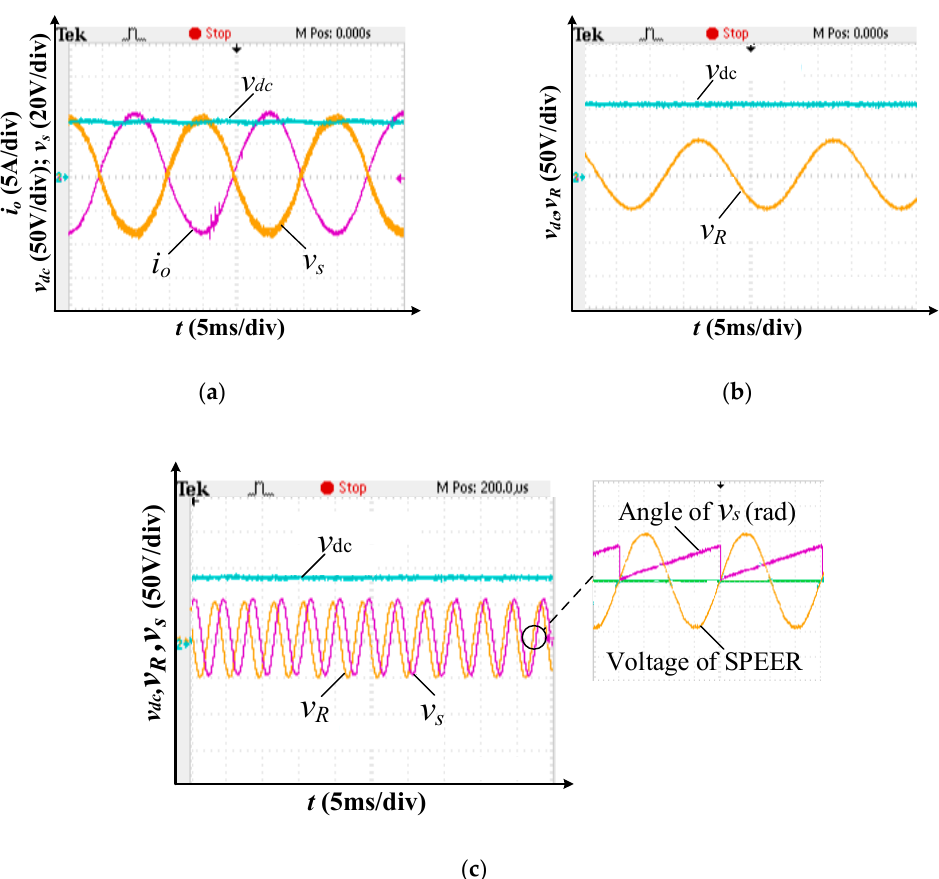
Figure 18. Experimental waveforms when SPEER starts: ( a ) grid-connected startup; ( b ) isolated network startup; ( c ) grid-connected pre-synchronization.